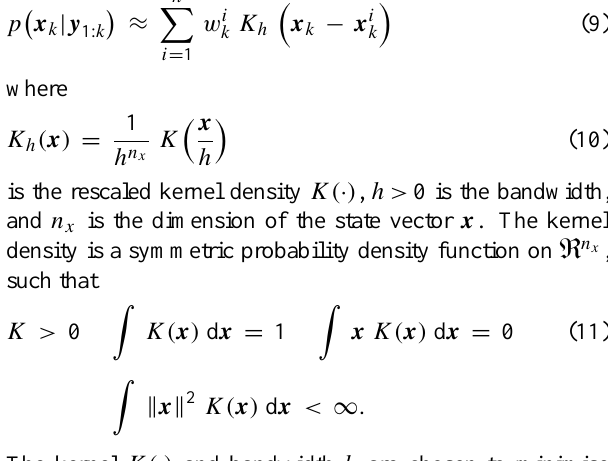
In RPF, posterior particles are drawn from the approximation